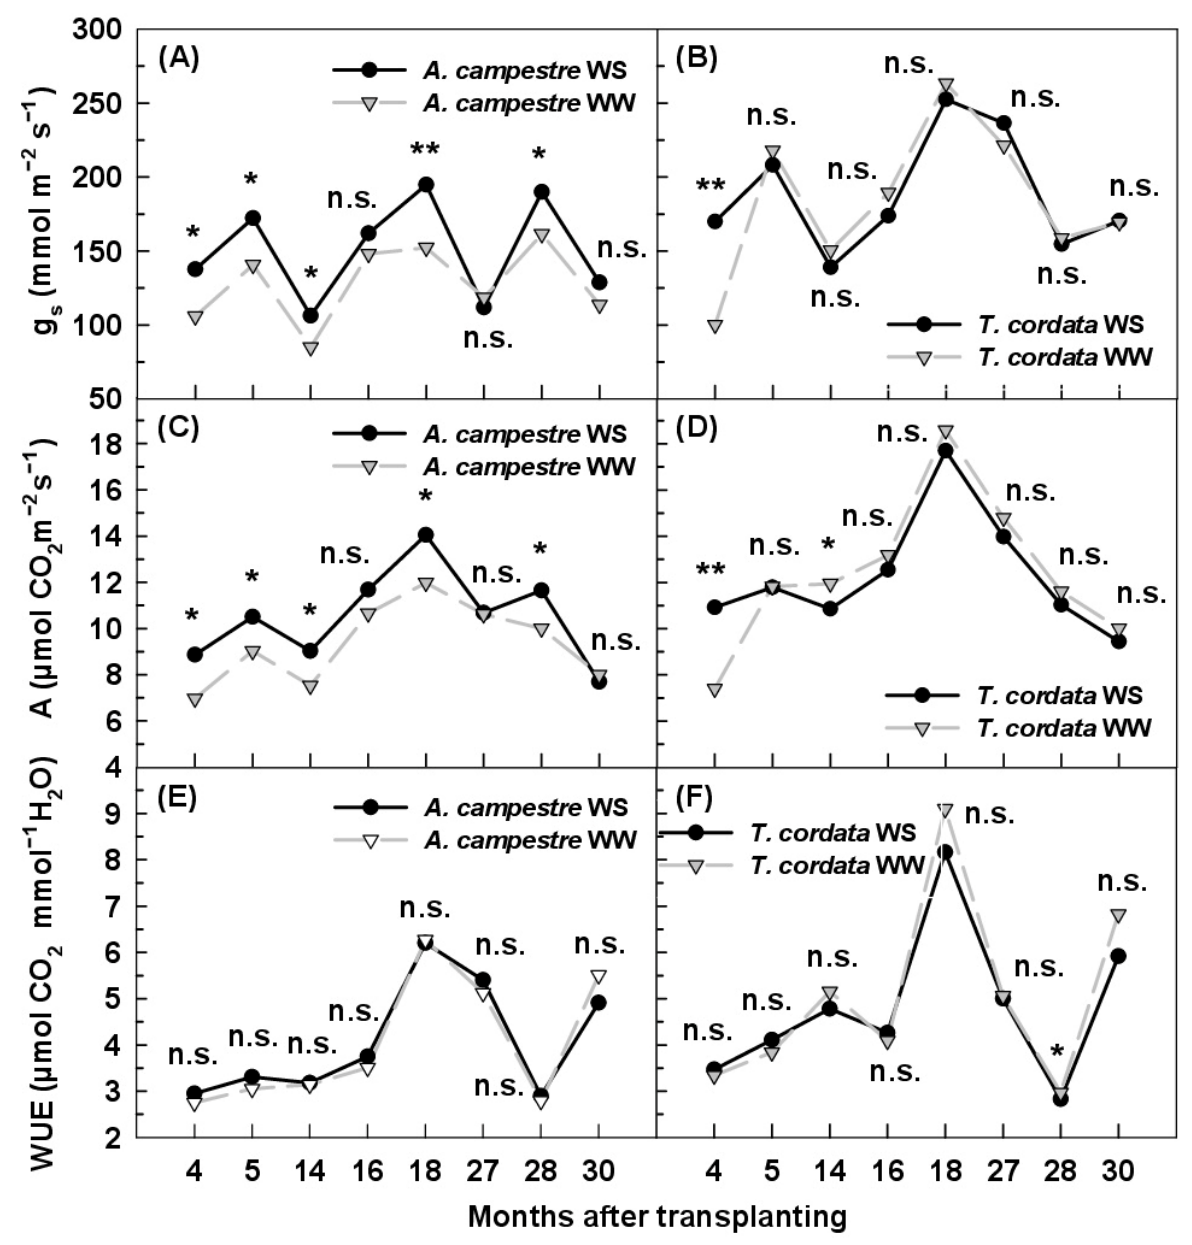
Figure 3. Effect of water regime in the nursery on stomatal conductance (g s , mmol m − 2 s − 1 ), carbon dioxide assimilation (A, μ mol CO 2 m − 2 s − 1 ) and water use efficiency (WUE, μ mol CO 2 mmol − 1 H 2 O) of Acer campestre L. ( A , C , E ) and Tilia cordata Mill. ( B , D , F ) transplanted in the field. Within each panel and sampling date, * and ** indicate significant differences between WW (well-watered) and WS (water-stressed) plants at p ≤ 0.05 and p ≤ 0.01, respectively; n.s. indicates no significant differences. In +I plants of Acer campestre (Figure 2), g s was higher than that of − I plants, with exceptions only occurring 16, 18 and 30 months after planting. +I Acer campestre showed higher A compared to − I plants throughout all of the experiment. WUE was higher in +I Acer campestre 4, 5, 18 and 28 months after transplanting compared to − I plants. Conversely, in Tilia cordata (Figure 2), the effects of mycorrhization were less clear. g s was higher in +I plants compared to − I plants only 28 months after planting. +I plants displayed higher A only soon after transplanting (4 months) and at the end of the experiment (28 and 30 months after transplanting). Similarly, 5, 28 and 30 months after transplanting, +I plants of Tilia cordata displayed higher WUE than − I